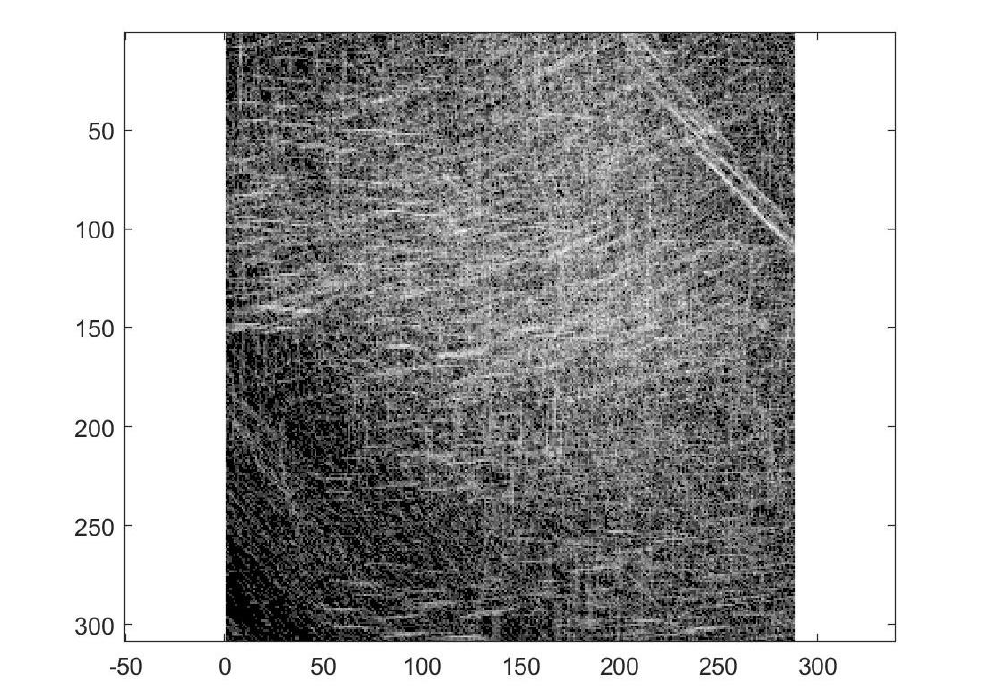
Figure 6. The complete accumulator space.